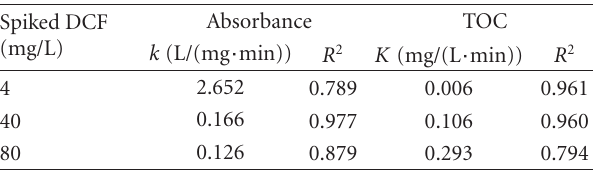
Table 2: Ozonation: degradation rate constants ( k , K ) for three di ff erent DCF